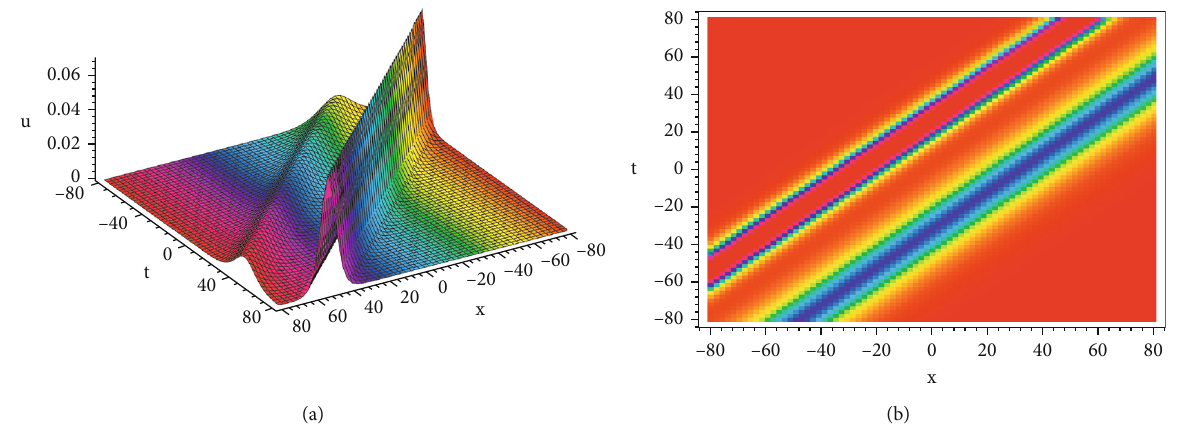
Figure 1: (a) Soliton molecule of the higher-order Boussinesq equation with the parameters (15). (b) Density plot of the corresponding soliton molecule.